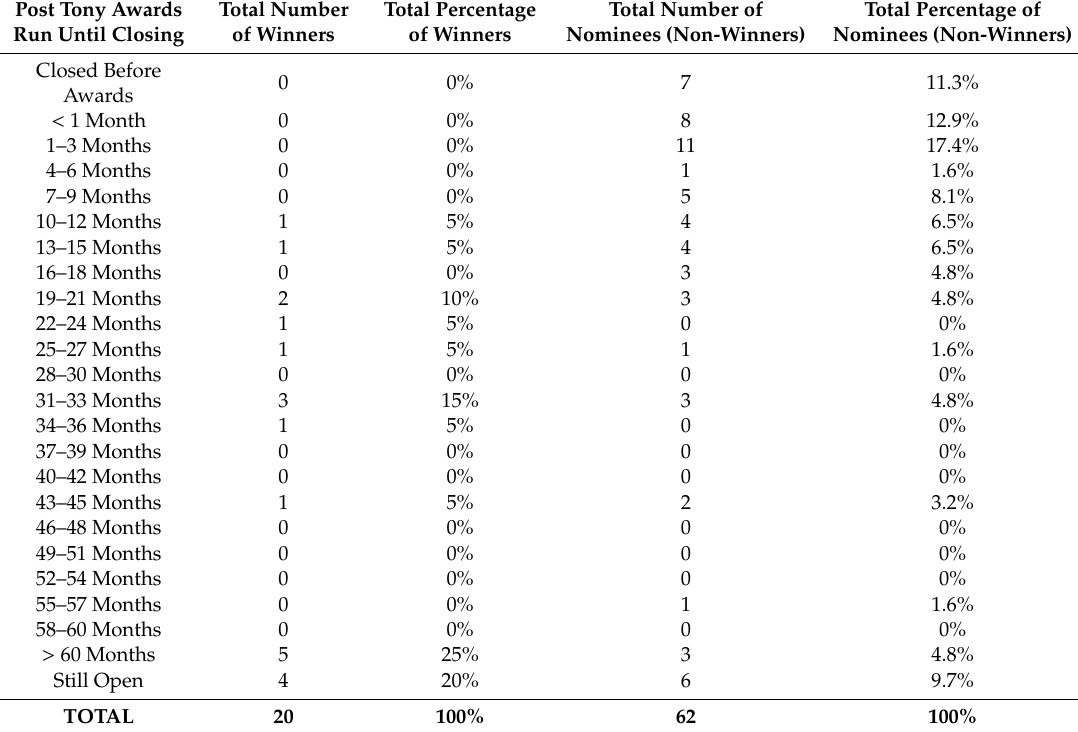
Table 4. Comparative lengths of original Broadway runs (in months) for ‘Best Musical’ Tony Award winners and nominees (non-winners) after corresponding Tony Awards ceremonies